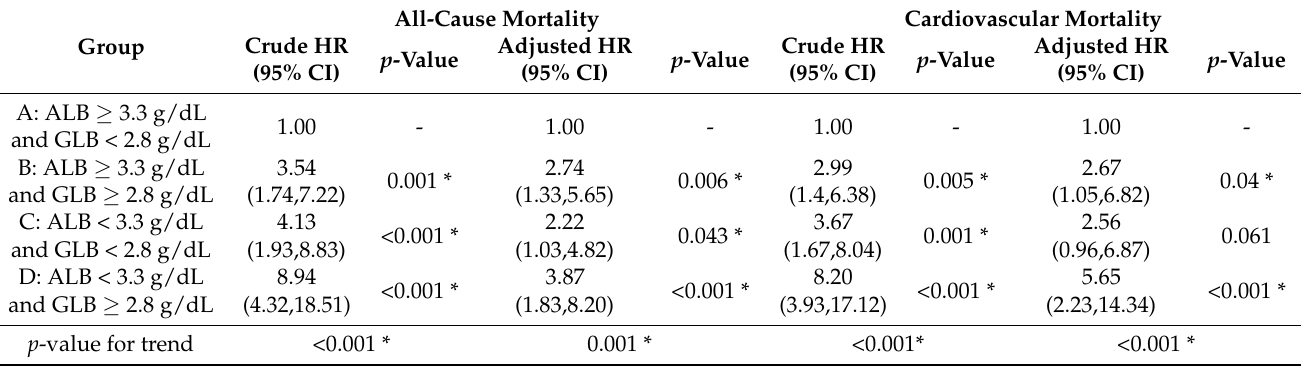
Table 2. Associations of the albumin–globulin groups with study outcomes by Cox